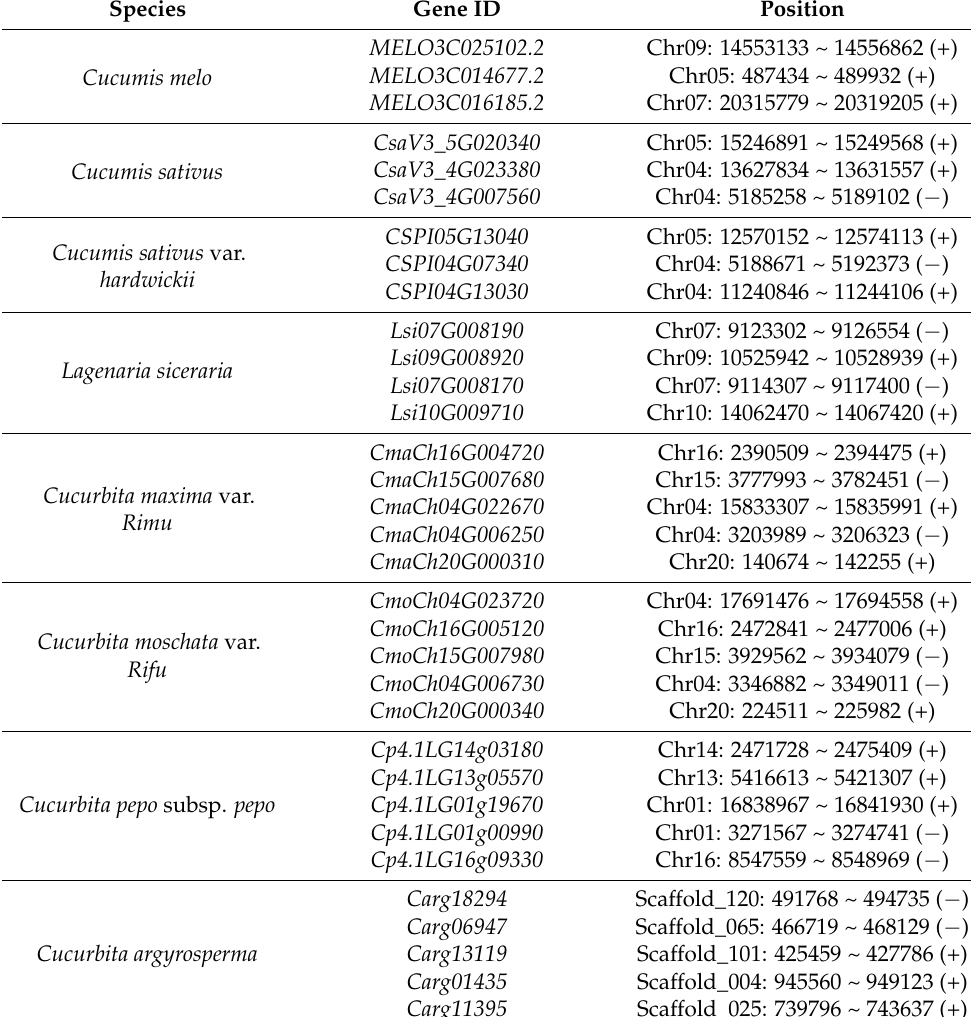
Table 3. PSYs in different Cucurbit family